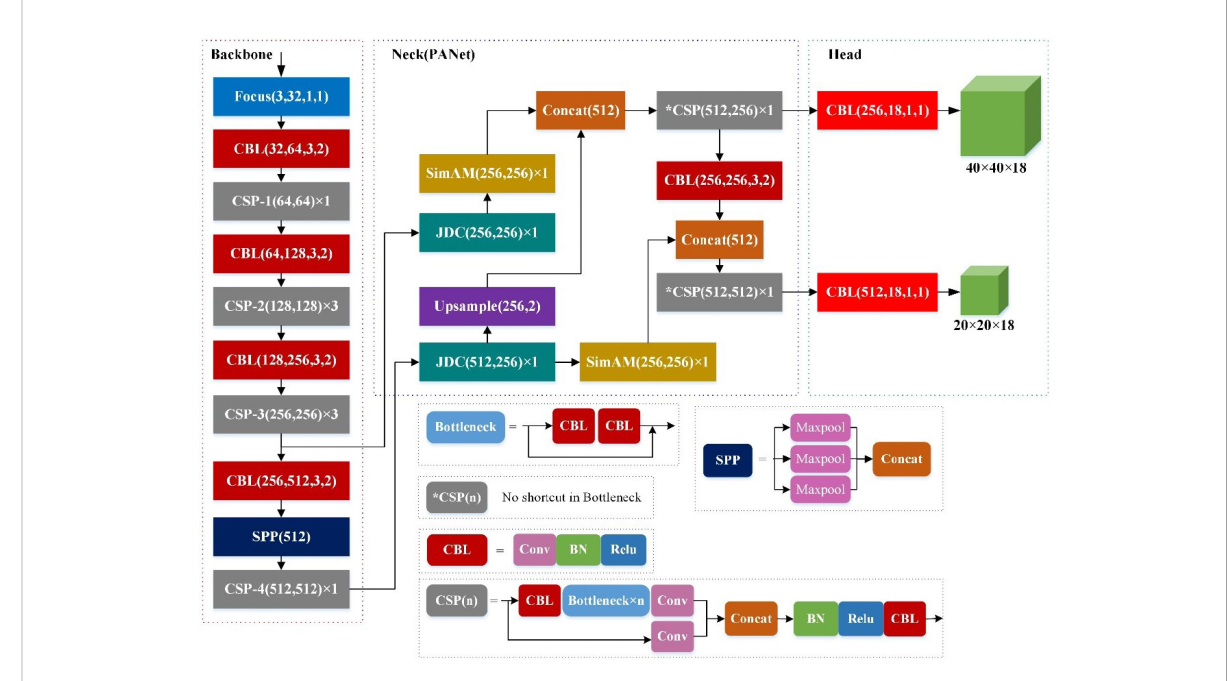
FIGURE 4 Schematic of the improved network model,